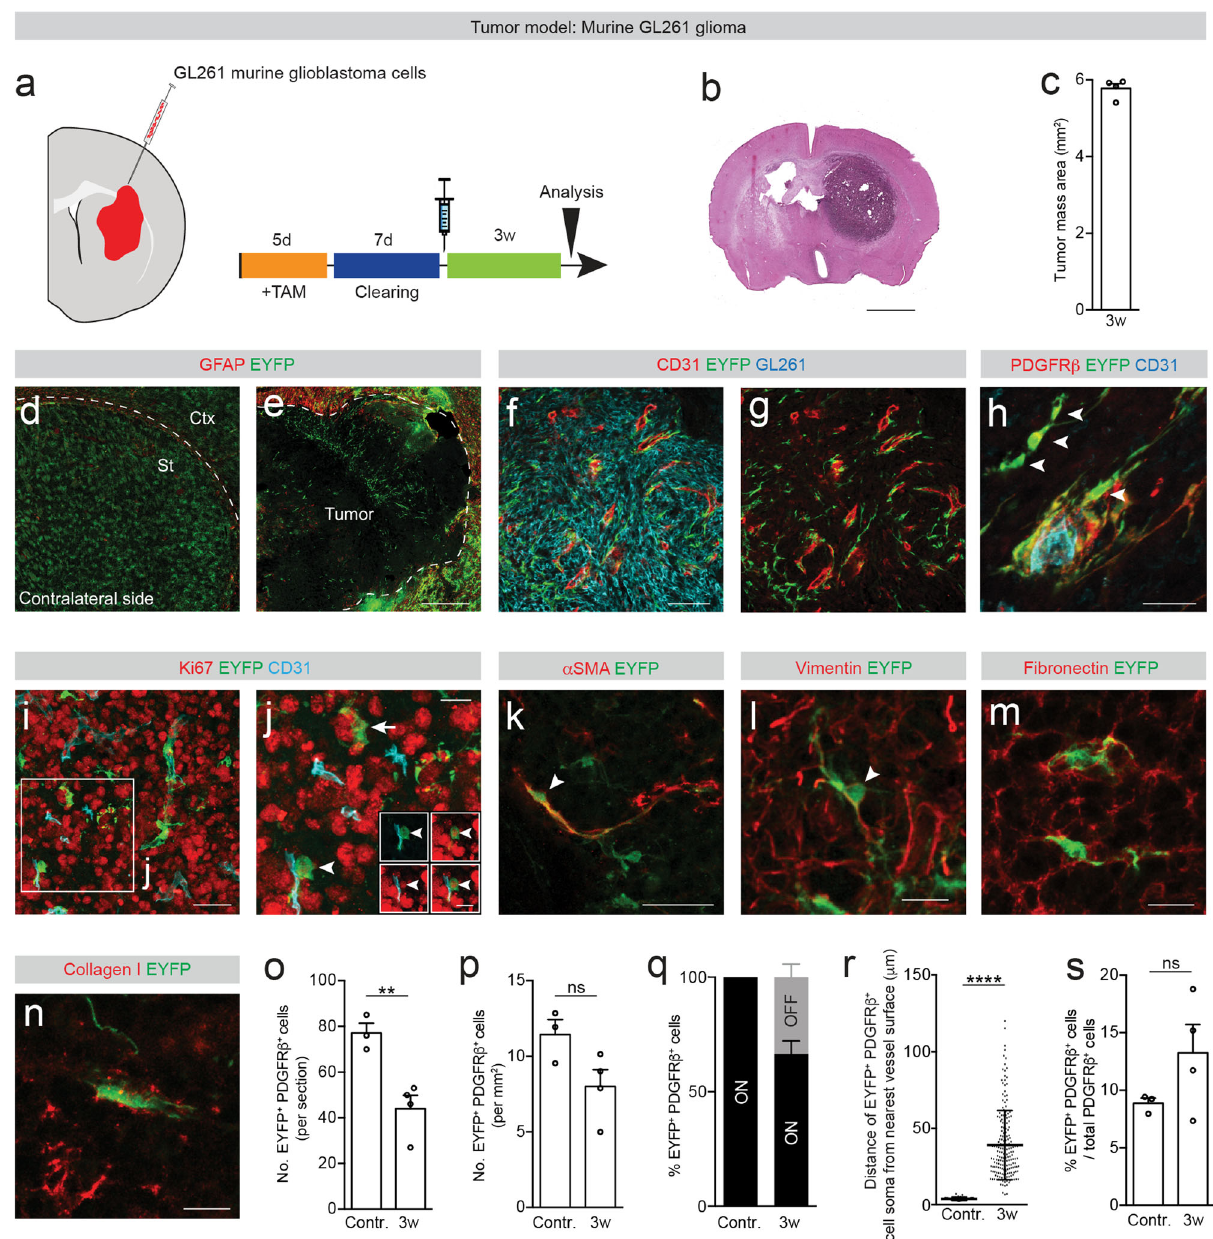
Fig. 7 Type A pericyte-derived cells contribute to the tumor stroma. a Glioblastoma model and experimental timeline. Red represents the tumor. b Tumor cell mass is con fi ned to the striatum (hematoxylin and eosin stain). c Area occupied by the tumor cell mass. Distribution of EYFP + cells in the contralateral ( d ) and ipsilateral ( e ) side to the tumor. Type A pericytes and progeny (EYFP + GFAP − ) are found within the tumor core, whereas partially recombined GFAP + reactive astrocytes border the tumor. Dashed line separates the cortex (Ctx) and striatum (St) in ( d ) and outlines the tumor core in ( e ). f , g EYFP + cells intermingle with GL261 tumor cells (labeled with an antibody against NG2 58 ). h A fraction of EYFP + PDGFR β + cells locates outside the vascular wall (arrowheads; endothelial cells marked by CD31), i , j EYFP + cells proliferate in contact (arrowhead) and away (arrow) from the vascular wall. Insets in ( j ) show a EYFP + cell associated with the vascular wall (CD31 + ) expressing the mitotic marker Ki67. EYFP + cells express α SMA ( k ; arrowhead) and vimentin ( l ), and are surrounded by fi bronectin ( m ) and collagen I ( n ) ECM. Number ( o ) and density ( p ) of EYFP + PDGFR β + cells in the tumor core and contralateral side. q Percentage of EYFP + PDGFR β + cells associated with (ON vessel) or located outside (OFF vessel) the vascular wall. r Distance of EYFP + PDGFR β + cells ON vessel (contralateral side to the tumor) or OFF vessel (tumor) from the nearest vessel surface. Each dot represents one cell. s Percentage of PDGFR β + cells that express EYFP out of total PDGFR β + cells. TAM tamoxifen; Scale bars: 1.5 mm ( b ), 200 μ m ( d , e ), 100 μ m ( f , g ), 50 μ m ( i , k ) and 20 μ m ( h , l , m , n , j and insets in j ). Data shown as mean ± s.e.m. n = 3 (Contralateral) and n = 4 (3w) animals in ( c , o , p , s ); n = 3 (Contralateral) and n = 5 (3w) animals in ( q ); n = 36 (Contralateral) and n = 189 (3w) cells examined over 3 animals in ( r ). ns non-signi fi cant; ** p < 0.01, **** p < 0.0001 by two-sided, unpaired Student ’ s t test in ( o , p , s ) and two-sided Mann – Whitney test in ( r ). f , g denote paired images. All images show coronal sections. Images are representative of two independent experiments. Source data and statistical test results are provided as a Source Data fi le.